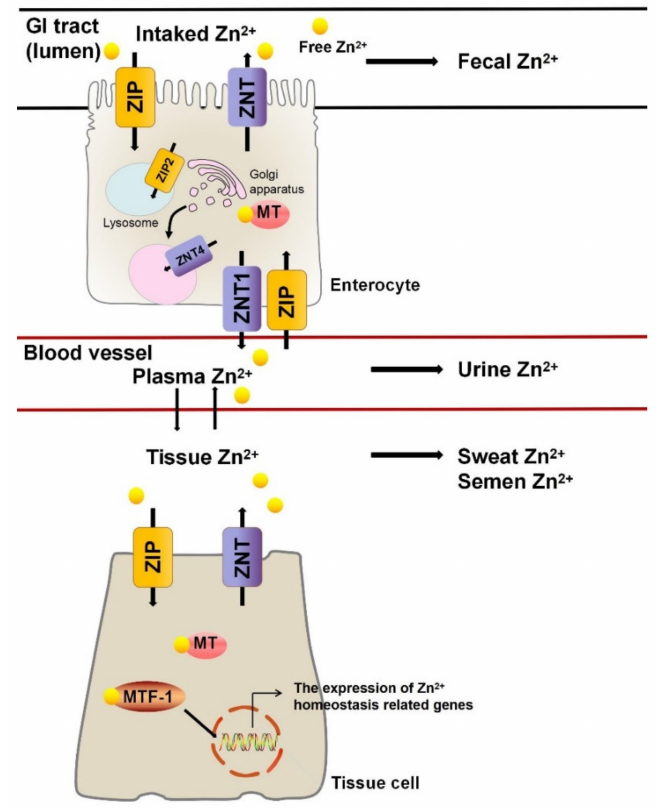
Figure 1. Regulation of Zn 2+ homeostasis. Zn 2+ from drinking water and diet is partially absorbed by intestinal cells in the gastrointestinal tract. Zn 2+ enters enterocytes via ZIPs and then leaves via ZNTs into the blood circulatory system. Along with the blood, Zn 2+ is distributed throughout the tissues. In tissue cells, MTF-1 transcription factor and MT are responsible for regulating Zn 2+ concentration. Unused Zn 2+ is mainly excreted in the form of feces, urine, sweat, and semen. GI, gastrointestinal; ZIP, Zrt- and Irt-like protein; ZNT, Zn 2+ transporters; MT, metallothionein; MTF-1, metal-responsive-element-binding transcription